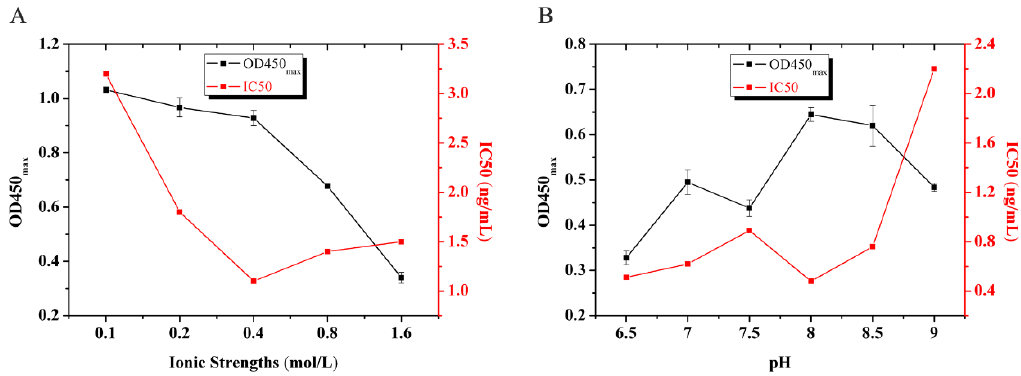
Figure 1. Effect of ionic strengths and pH values on the performance of the assay. The standard deviation (SD) of ( A ) were [0.1 (0.0111), 0.2 (0.0349), 0.4 (0.0282), 0.8 (0.0068), 1.6 (0.0202)]; The SD of ( B ) were [6.5 (0.0153), 7.0 (0.0267), 7.5 (0.0183), 8.0 (0.0151), 8.5 (0.0450), 9.0 (0.0086)].